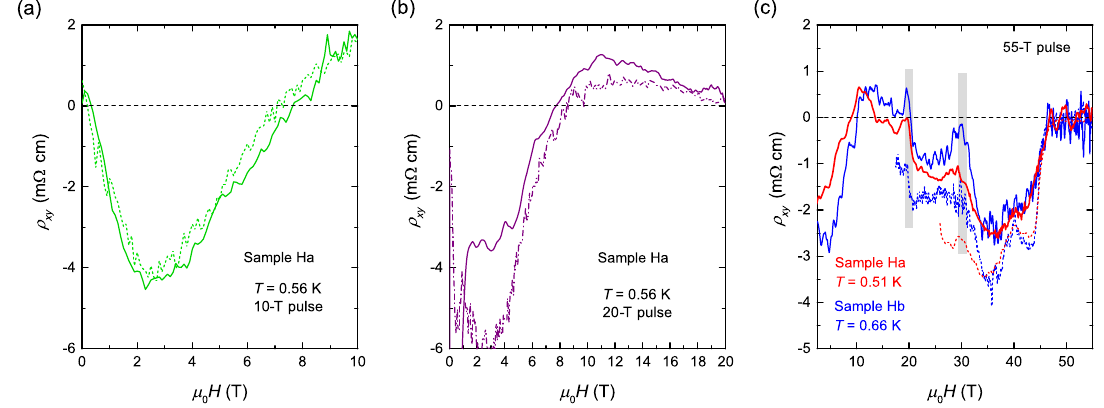
FIG. 3. Field dependence of Hall resistivity in YbB 12 measured in pulsed magnetic fields for (a) sample Ha at 0.56 K up to 10 T, (b) sample Ha at 0.56 K up to 20 T, (c) sample Ha at 0.51 K, and sample Hb at 0.66 K in magnetic fields of up to 55 T. Solid and short- H Þ curves are obtained by subtracting the negative from the dashed lines are field up sweeps and down sweeps, respectively. The ρ xy ð positive field sweeps. The two light gray bars in (c) mark the fields corresponding to possible Lifshitz